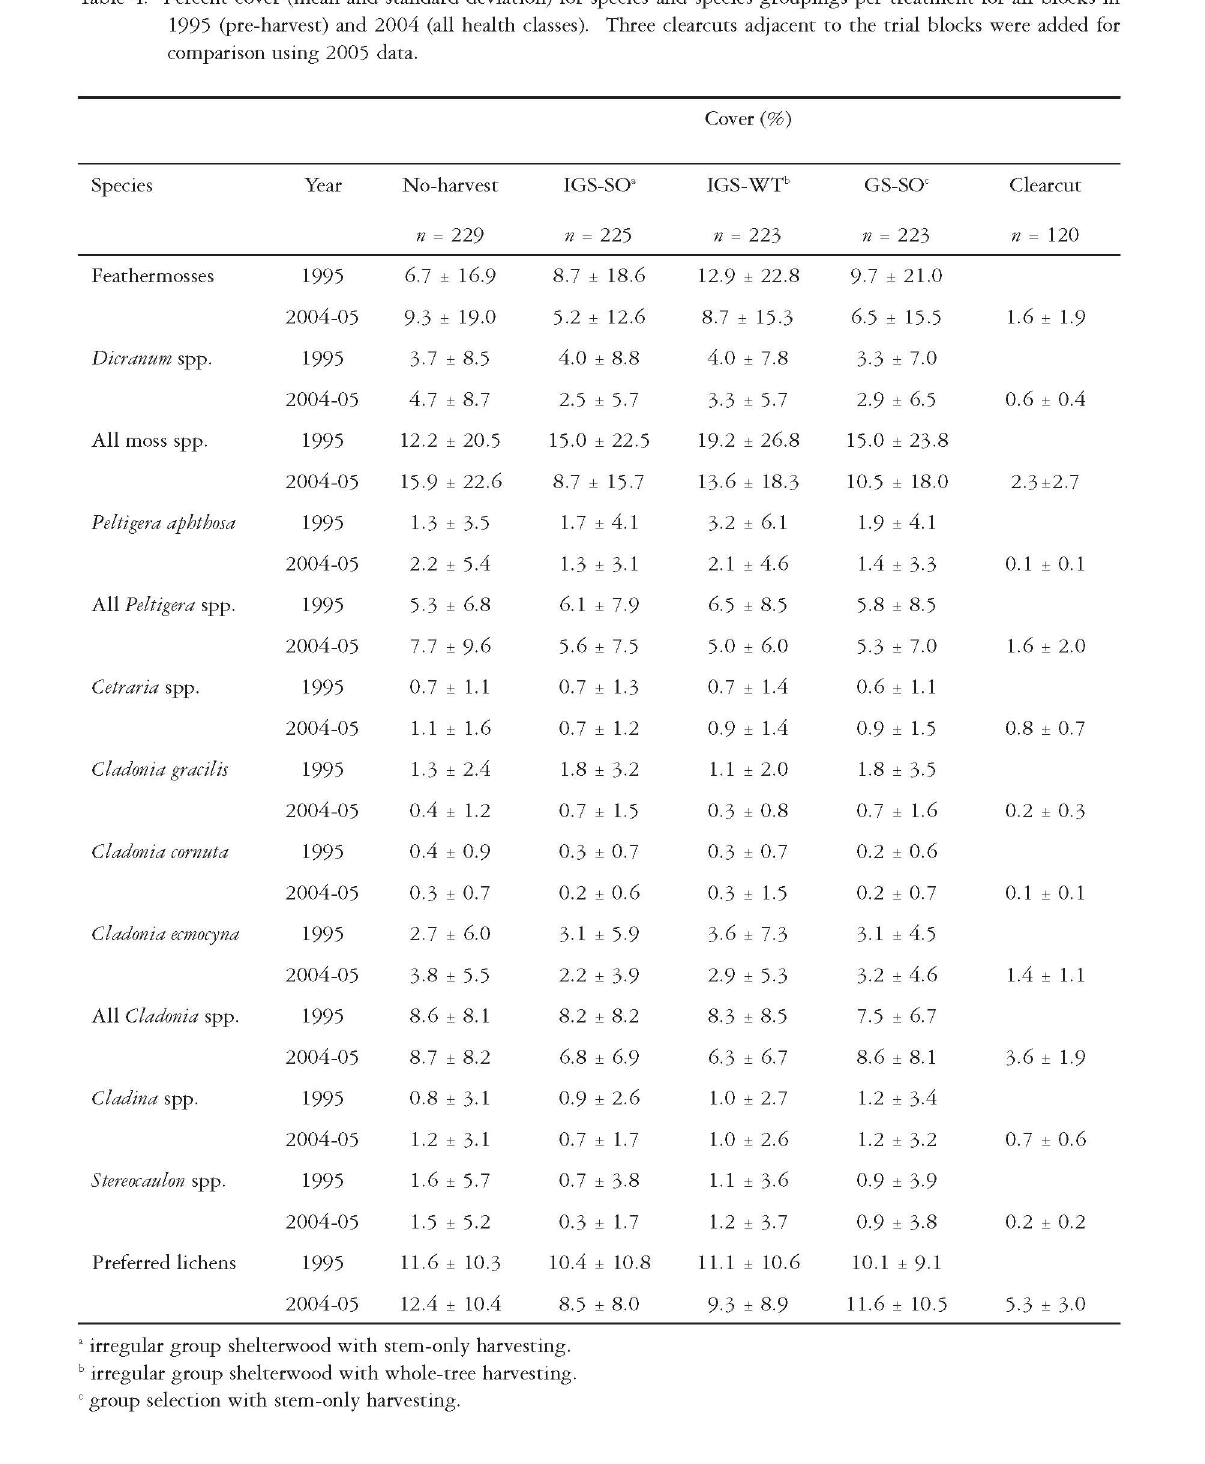
Table 4- Percent cover (mean and standard deviation) for species and species groupings per treatment for all blocks in 1995 (pre-harvest) and 2004 (all health classes)- Three clearcuts adjacent to the trial blocks were added for comparison using 2005